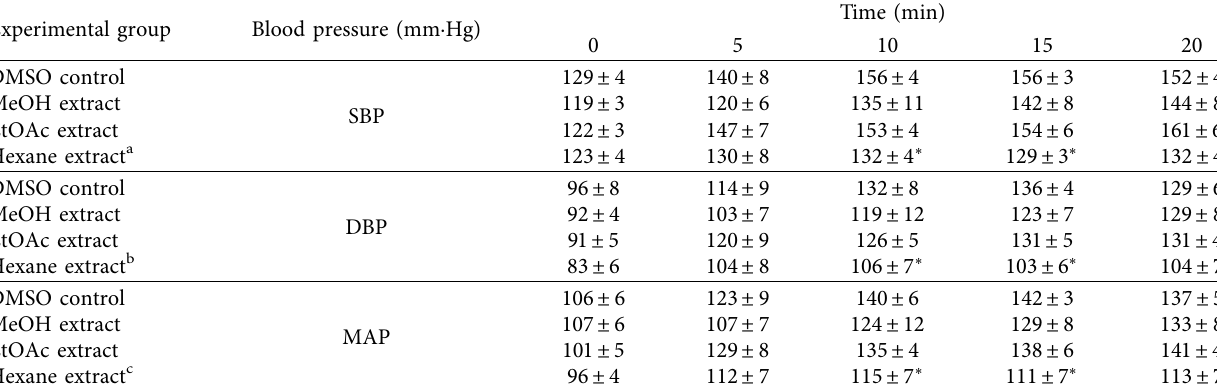
Table 2: The effects of crude extracts from Salvia serotina L. on SBP, DBP, and MAP when administered intravenously at 50mg/kg BW in